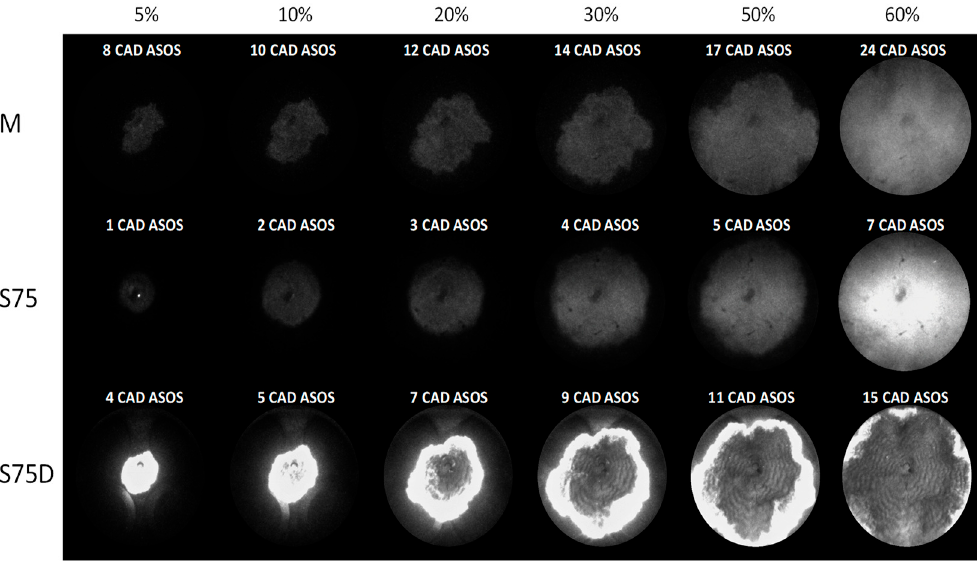
Figure 12. Image sequence of flame evolution at the same flame area (5%, 10%, 20%, 30%, 50% and 60% of the piston area) for a lean air-fuel ratio ( λ = 1.4) with M, S50, and S50D fueling.